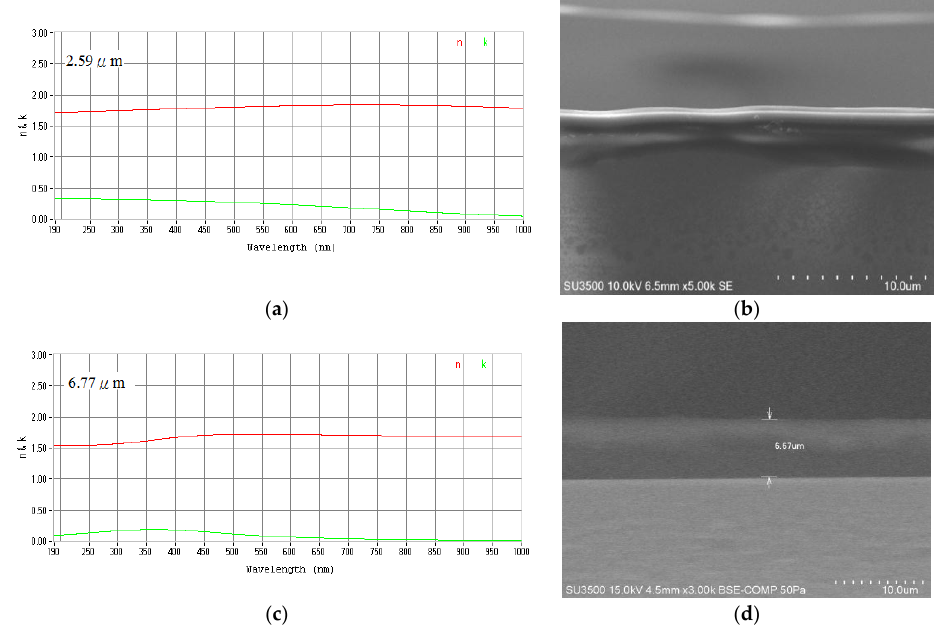
Figure 7. Refractive index ( n ) and extinction coefficient ( k ) of poly(Ti–O–Si precursor-co-OPPEA) hybrid films with thicknesses of ( a ) 2.59 and ( b ) 6.77 μm. The estimated thickness was confirmed by the cross-section view of films in the SEM image.